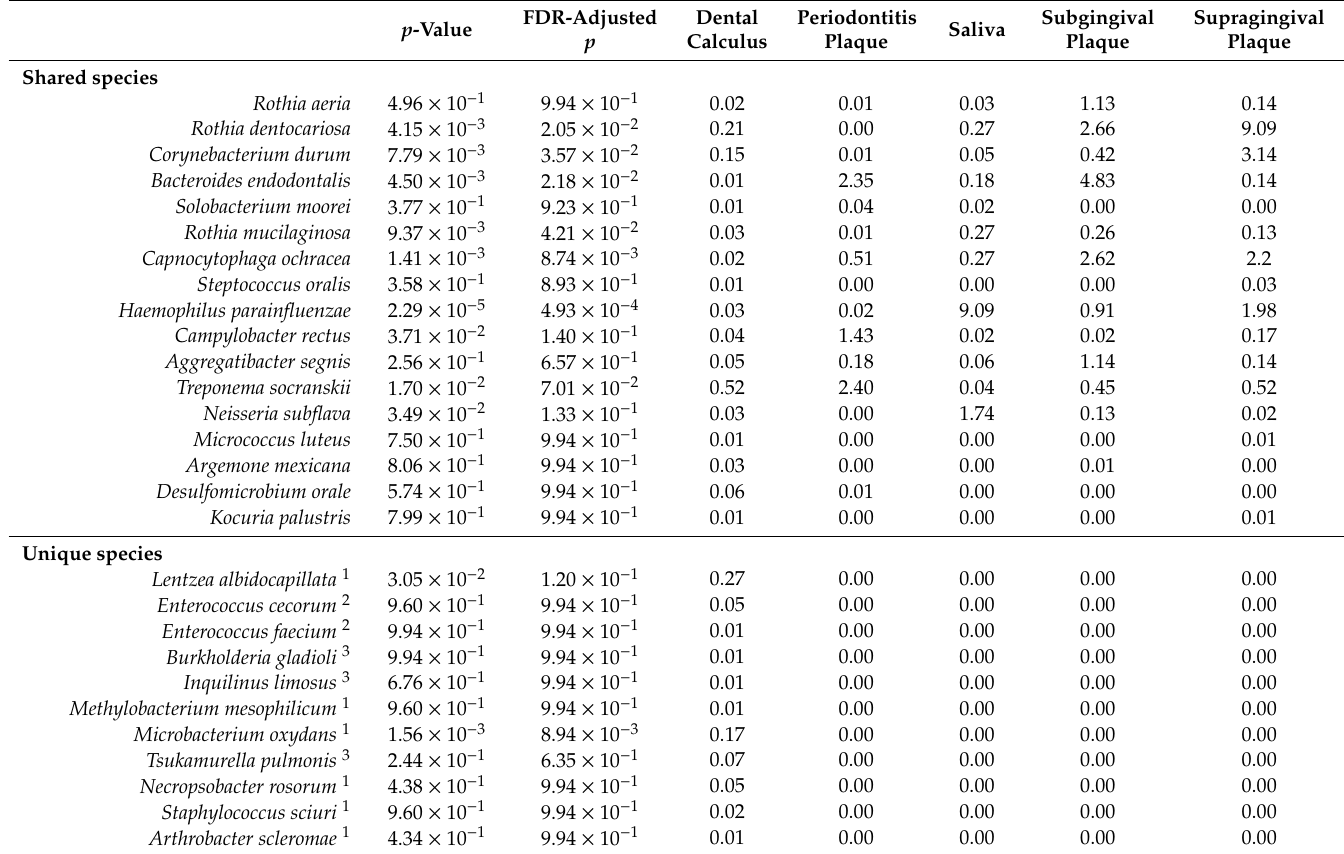
Table 2. Group significance analyses based on sample type. Results show the average relative abundances of selected bacterial species that are shared between the dental calculus samples and the modern oral microbiomes including dental plaque from subjects with and without periodontitis, as well as saliva (shared species). Results also show selected bacteria that were only identified in the dental calculus samples (unique species). p -Value and False Discovery Rate (FDR)-Adjusted p values are